Question: Name the type of graph shown.
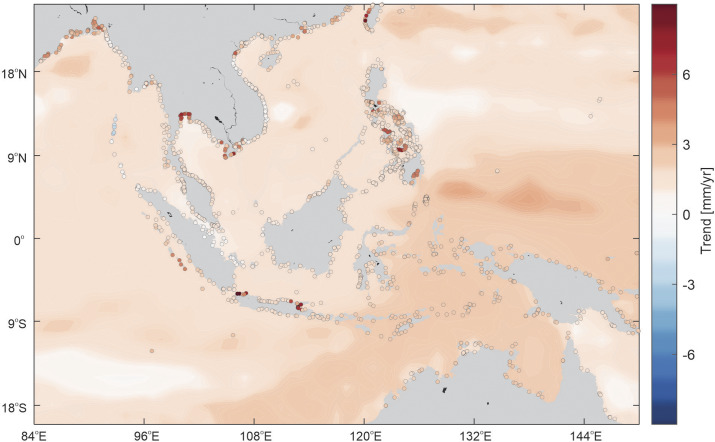
Answer: line